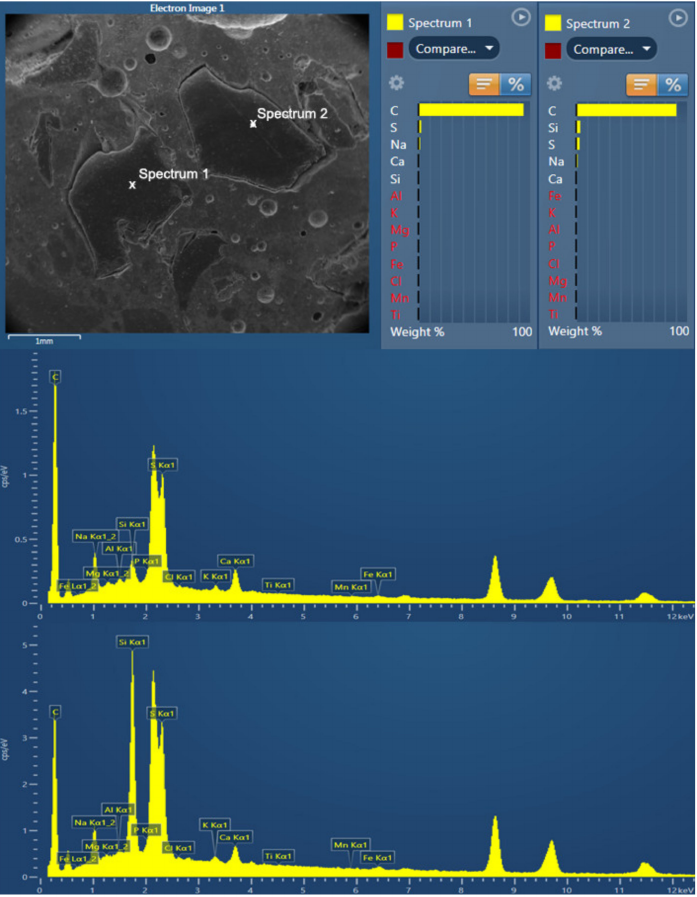
Figure 6. EDS analysis for the identification of crumb rubber aggregates in the mortar